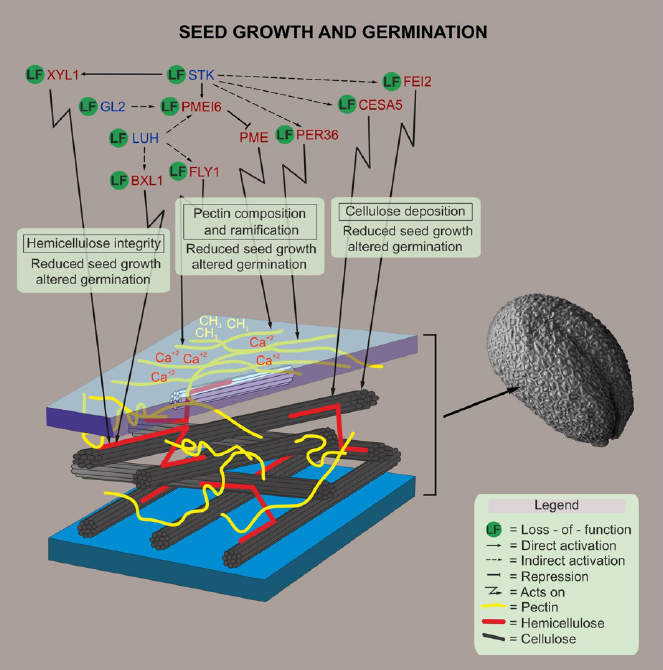
Figure 5. Proposed model. A schematic representation of the genes involved in CW polysaccharide remodeling, and how their mutations affect seed development and germination, are shown based on results presented in this work, as well as on genetic and biochemical evidences shown previously in the literature [28,29,31,35,57]. Blue letters indicate the transcriptional regulators, red letters indicate proteins with enzymatic activity, and dark blue indicates a protein without enzymatic